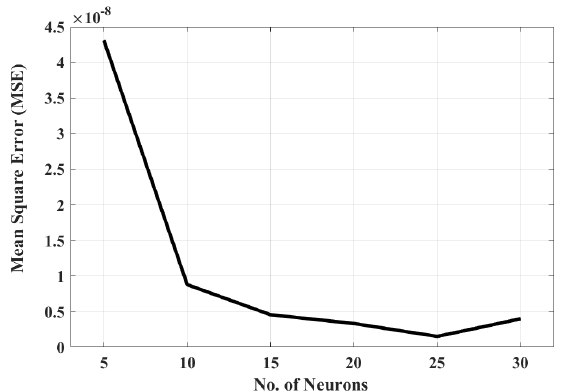
Figure 2. Plot of MSE with different number of hidden layer neurons. Processes 2021 , 9 , x FOR PEER REVIEW Table 1. Specification of the proposed ANN model.